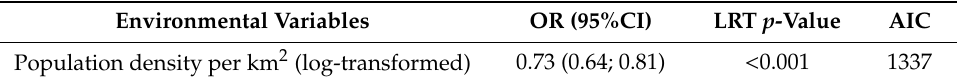
Table A2. Multivariable analysis of the association between CHIK seroprevalence and environmental variables using 3km bu ff ers around villages. The models were adjusted for population density (log-scale) and clustering of individuals in villages (random intercept).